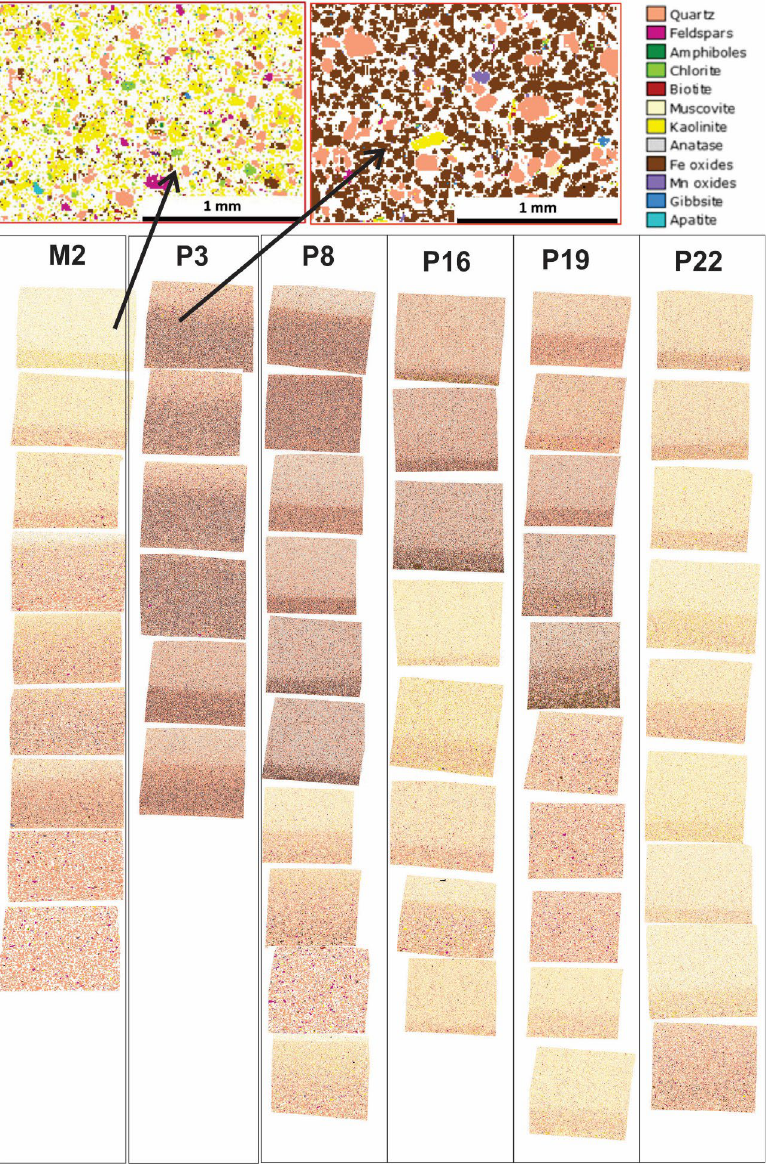
Figure 11. Comparative chart of mineralogical images obtained by QEMSCAN measurements of the sediments samples.